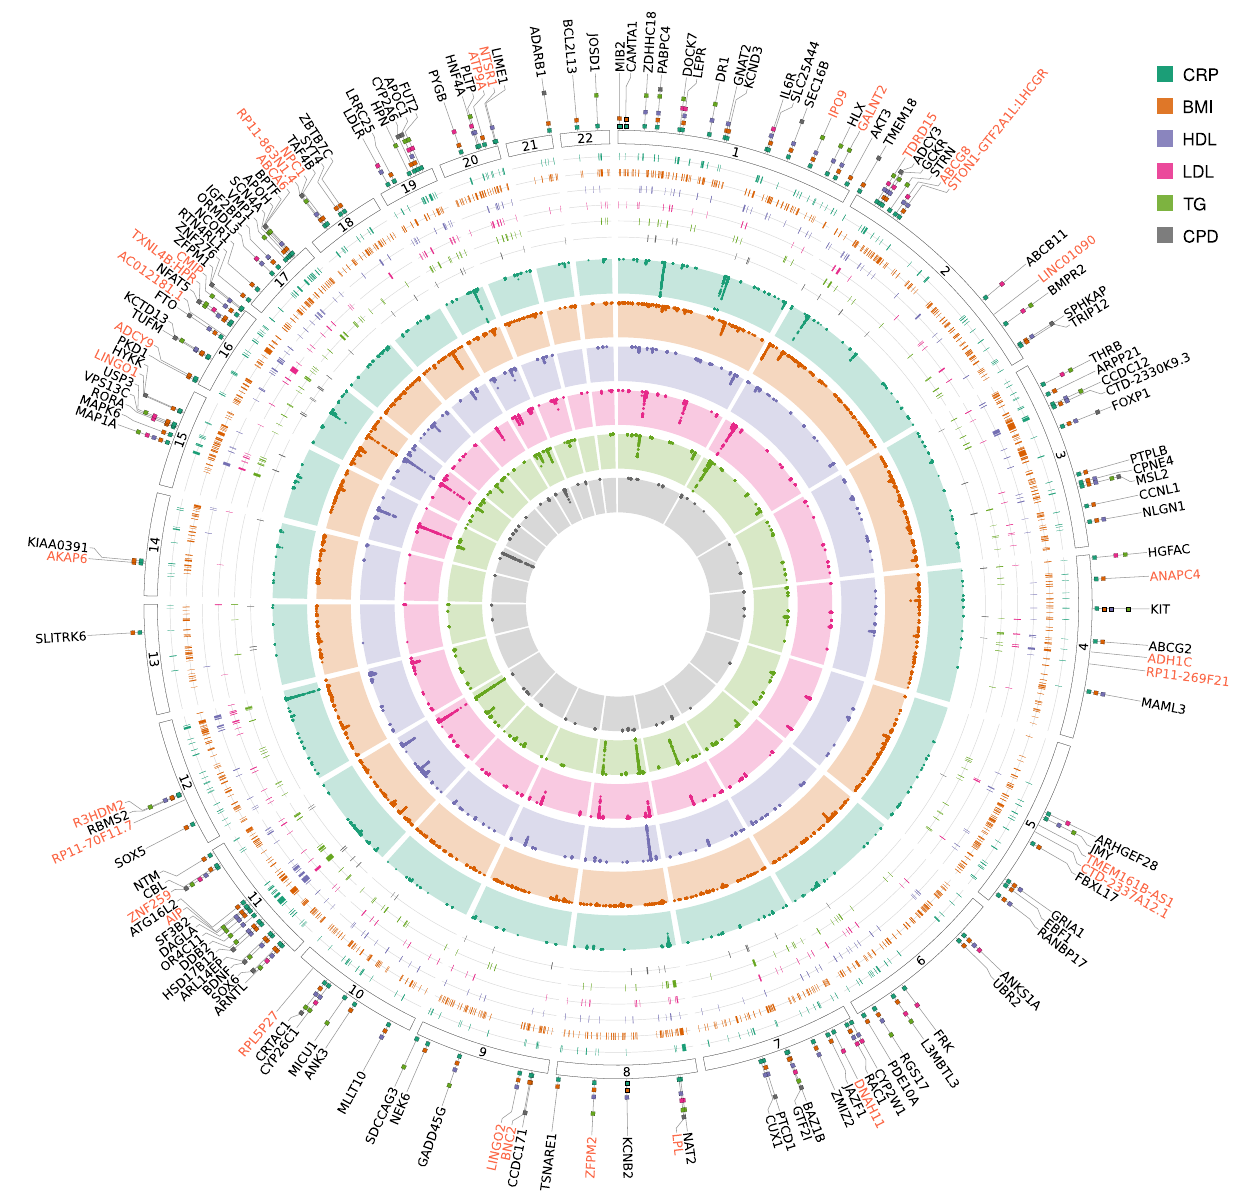
Fig.2|CircularplotwithMTAGresultsbetweenC-reactiveproteinlevels,high- density lipoprotein levels, low-density lipoprotein levels, triglyceride levels, bodymassindexandcigarettesperday. Theinnerpartofthegraphpresentsthe Manhattanplotsofthegenome-widesigni fi cantvariants( P <5×10 − 8